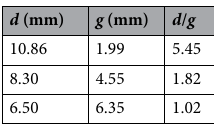
Table 1. Rods’ diameter ( d ), gap between rods ( g ) for each arrangement. The tolerance is 0.05 mm.